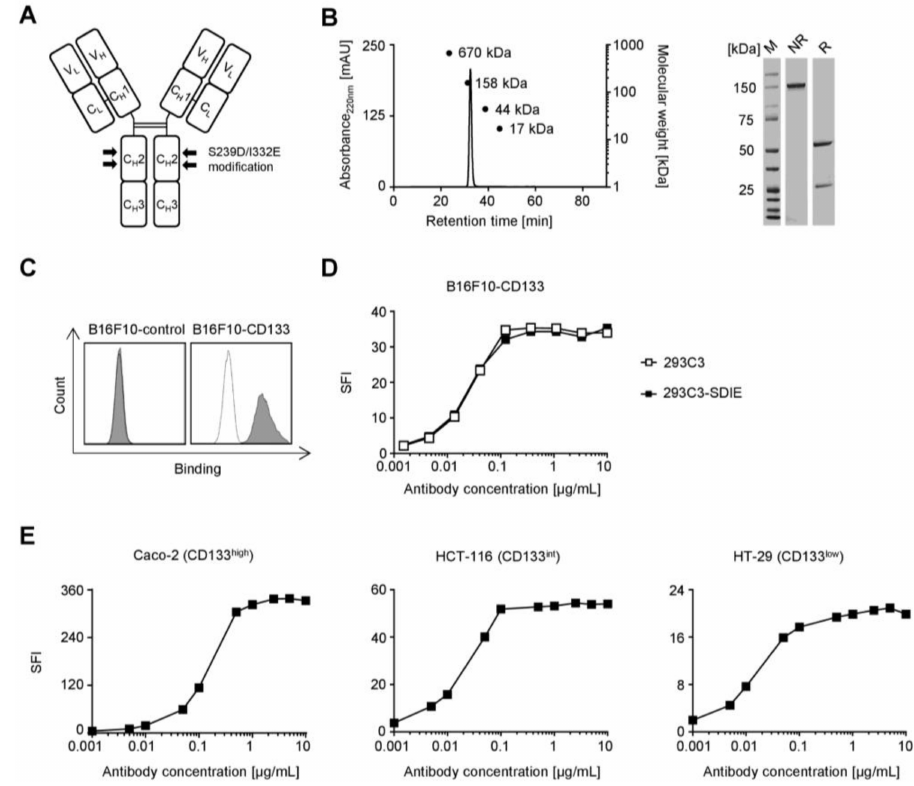
Figure 2. Generation and characterization of 293C3-SDIE in colorectal cancer (CRC). ( A ) Schematic illustration of 293C3-SDIE. ( B ) Purified 293C3-SDIE was analyzed by size exclusion chromatography (left) and SDS-PAGE (right). mAU: milli absorption unit; R: reduced; NR: non-reduced; M: marker. ( C ) B16F10-CD133 and B16F10-control transfectants were incubated with 10 µ g / mL 293C3-SDIE or Iso-SDIE followed by an anti-human phycoerythrin (PE) conjugate. Shaded peaks: 293C3-SDIE; open peaks: Iso-SDIE. ( D ) B16F10-CD133 transfectants were incubated with the indicated concentrations of 293C3 or 293C3-SDIE and their respective isotype controls followed by an anti-mouse or anti-human PE conjugate. ( E ) The colorectal cancer (CRC) cell lines Caco-2 (CD133 high : left), HCT-116 (CD133 int : middle), andHT-29(CD133 low : right)wereincubatedwiththeindicatedconcentrationsof293C3-SDIEor Iso-SDIE followed by an anti-human PE conjugate. Int: intermediate; SFI: specific fluorescence